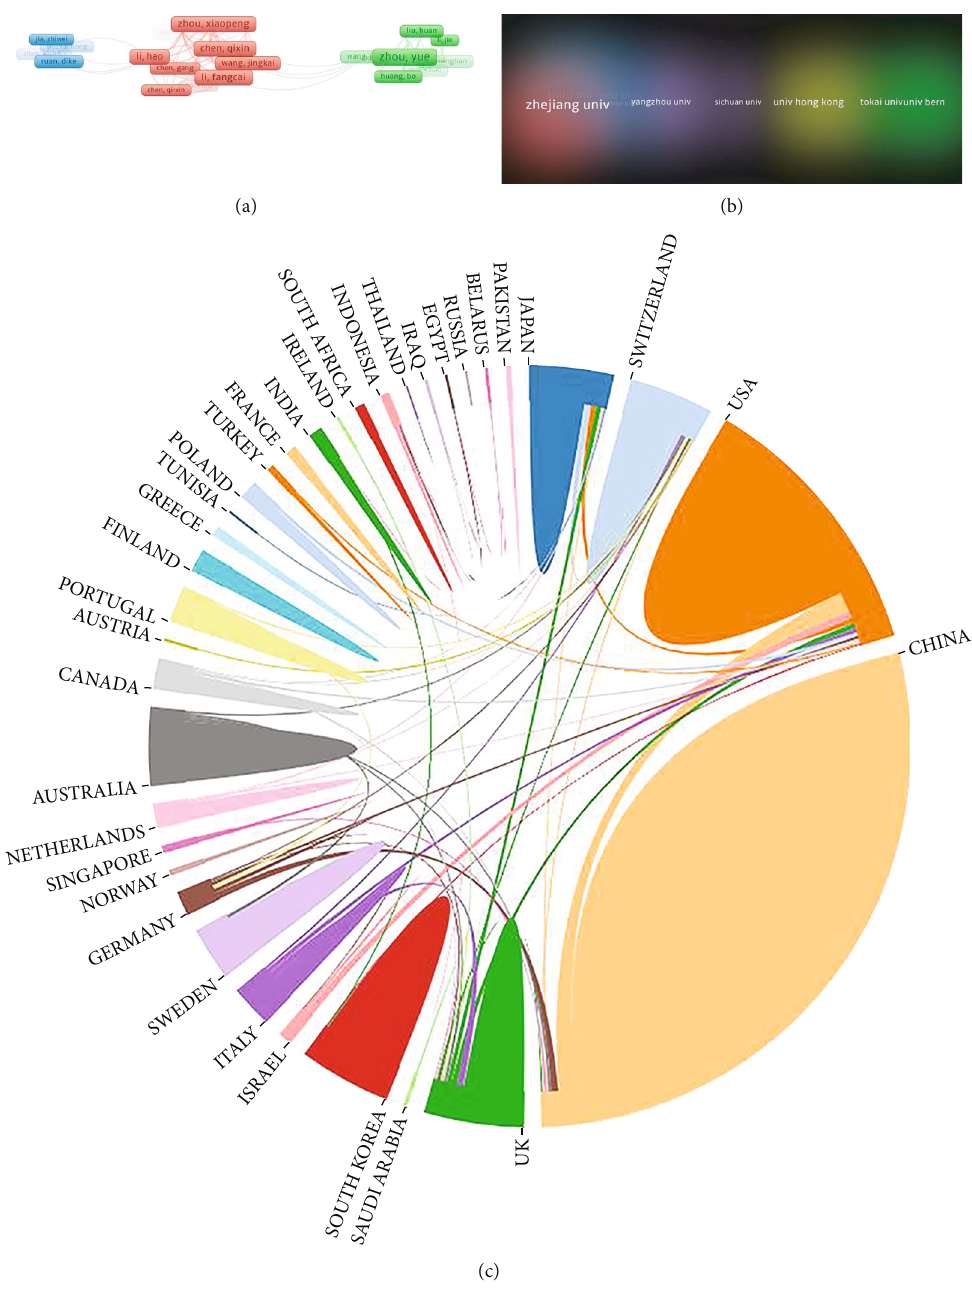
Figure 3: The co-authorship analysis of (a) authors, (b) organizations, and (c) countries on stem and progenitor cells in intervertebral discs. (The size of the frames represents the proportion of the author in the analysis. The larger the frames, the greater the contribution. The line between the frames represents the connection between the authors. The more or thicker the line, the stronger the connection. The color of the area where organization is located represents the connection between organizations. The darker the color, the closer the collaboration organization; the larger the area, the greater the